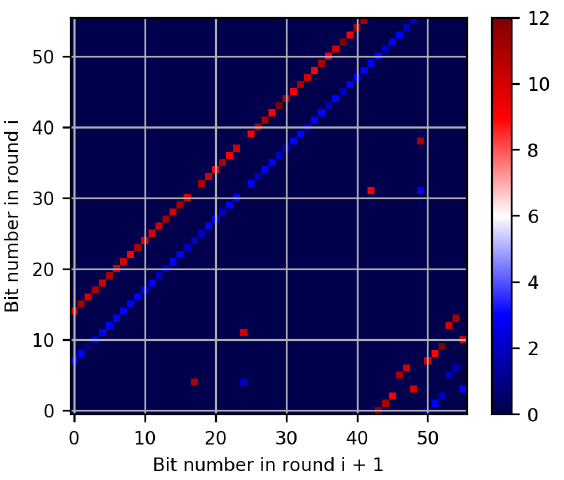
Figure 7: Matrix showing the occurrence frequency of transitions between successive round key bits. Strong transitions in red, weak transitions in blue.